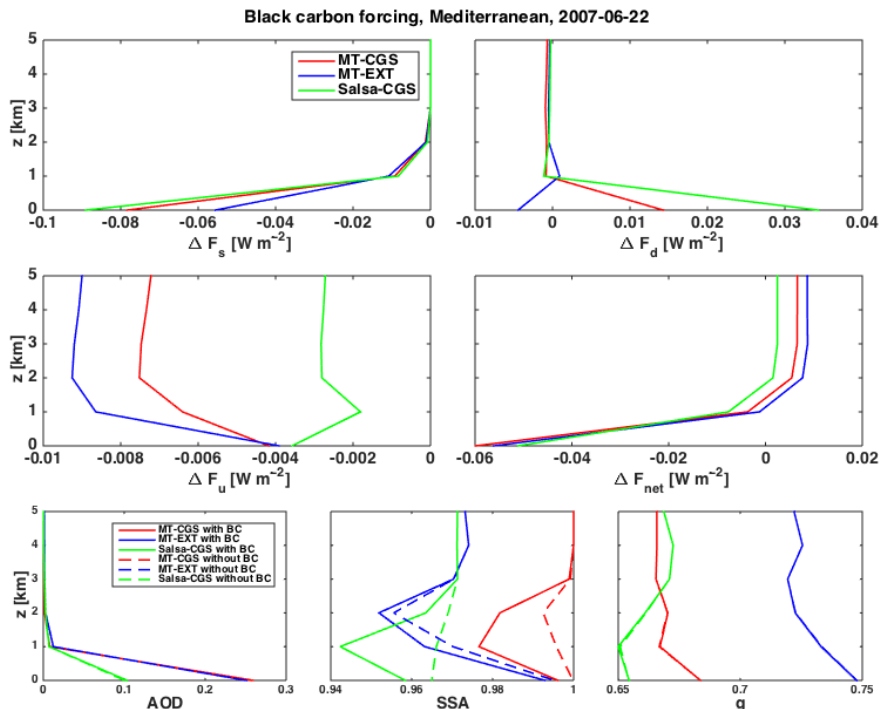
Figure 10. Same as Fig. 9 but over the Mediterranean.